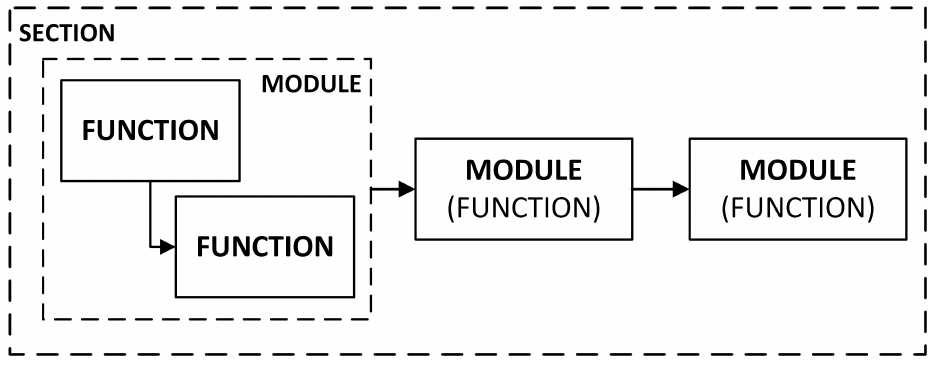
Figure 1. Proposed structures of the software components and their